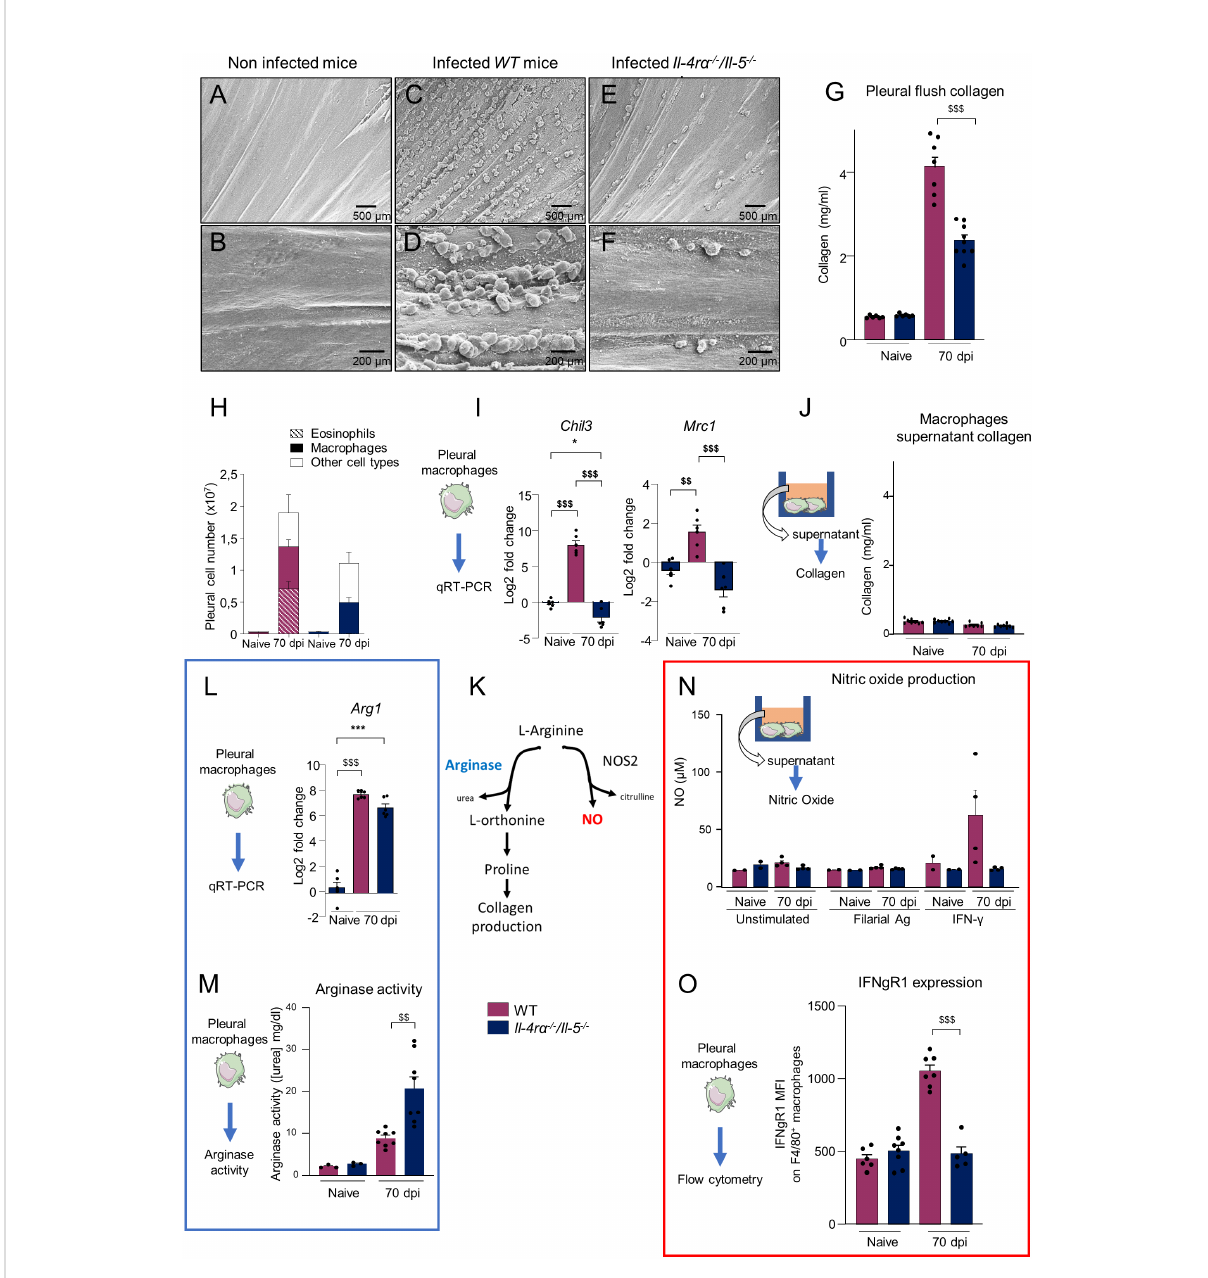
FIGURE 2 Il-4r a -/- /Il-5 -/- mice showed decreased pleural pathology and altered balance of the arginine metabolic pathway. WT and Il-4r a -/- /Il-5 -/- BALB/c mice were infected with L. sigmodontis and pleural cavity pathology and macrophages were investigated 70 days post infection (dpi). (A – F) Scanning Electron Microscopy images of the parietal pleura: (A, B) Smooth pleura in naive mice; (F, I) high density of polyps in 70 dpi WT mice, and (E, F) rare polyps in 70 days-infected Il-4r a -/- /Il-5 -/- mice. (G) Collagen measurement in the pleural cavity fl ush. (H) Total number of F4/80 + macrophages and Siglec-F + eosinophils as determined by fl ow cytometry. (I) Expression of prototypical markers of alternative activation Chil3 and Mrc1 in pleural macrophages determined by qRT-PCR. (J) Collagen measurement in macrophage culture supernatant after 24h culture in vitro . (K) Simpli fi ed arginine metabolic pathway, adapted from (47, 48). (L) Expression of Arg1 by pleural macrophages determined by qRT-PCR. (M) In vitro arginase activity in pleural macrophages. Arginase activity was measured using QuantiChrom Arginase assay kit. (N) In vitro nitric oxide (NO) production ( m M) from pleural macrophages after incubation for 16h with or without IFN- g or fi larial antigen (10µg/ml). (O) Mean fl uorescence intensity (MFI) of IFNgR1 expression on F4/80 + pleural macrophages. Dots represent individual mice and results are expressed as mean ± SEM. (A – F) Images are representative of n=3 mice per group. (H) Pool of 4 – 6 independent experiments n=20-27 mice per group. (J) n = 10. (I, L) , n=6 per group. Two-way ANOVA: *p<0.05, ***p<0.001 represent differences between group; $$ p<0.01, $$$ p<0.001 represent differences between mice strains. (N) n=2-4 mice per group. (O) n =